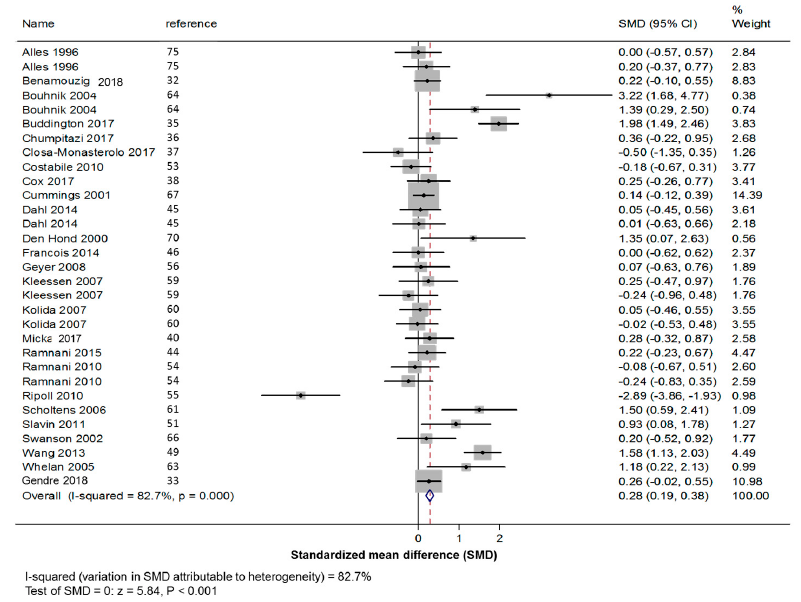
Figure 2. Forest plot for the effect of all β -fructans on stool frequency. SMD: standardized mean difference (number of bowel movements/day); CI: confidence interval.